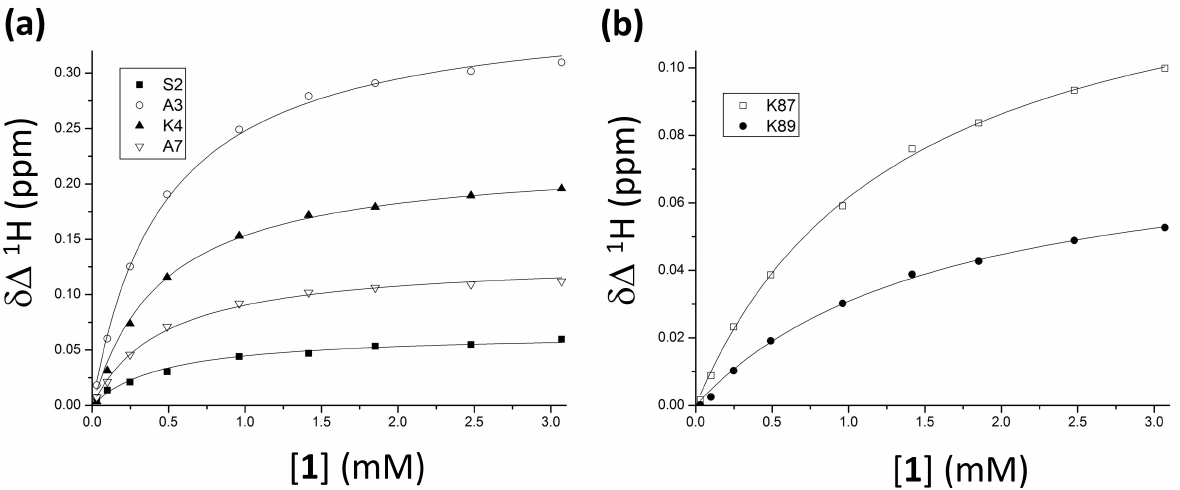
Figure 4. Experimental points and calculated binding curves for the two binding sites including ( a ) the group of residues around K4, and ( b ) K87 and K89. The experimental Δδ were fitted as a function of the concentration of 1 to a 1:1 binding model.